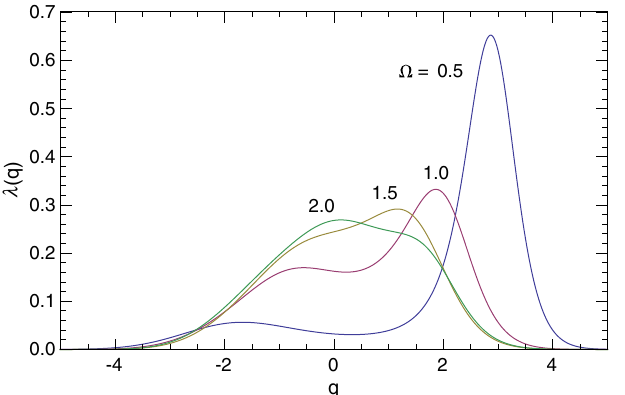
FIG. 3. For the CSR wake, threshold value of S csr vs shielding =h 3 = 2 . Symbols give results of the VFP parameter, (cid:1) ¼ (cid:11) 1 = 2 (cid:6) z 0 solver (blue circles), the LV code (red squares), and the VFP solver with twice stronger radiation damping (olive